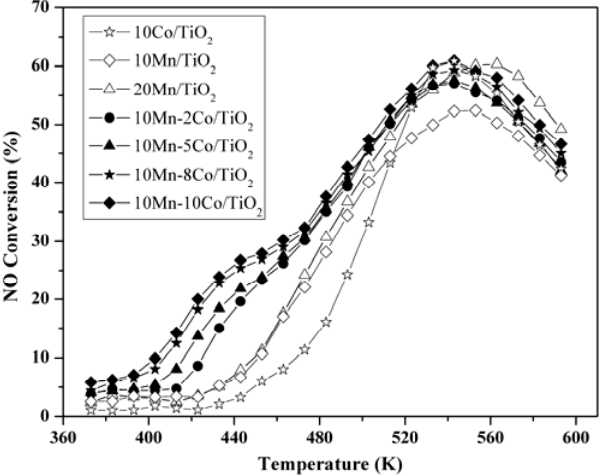
Figure 1. NO oxidation efficiency of Mn-Co/TiO 2 catalysts with different Co contents. Reaction conditions: [NO] = 400 ppm, [O 2 ] = 5%, Ar balance, GHSV = 42,000 h − 1 .